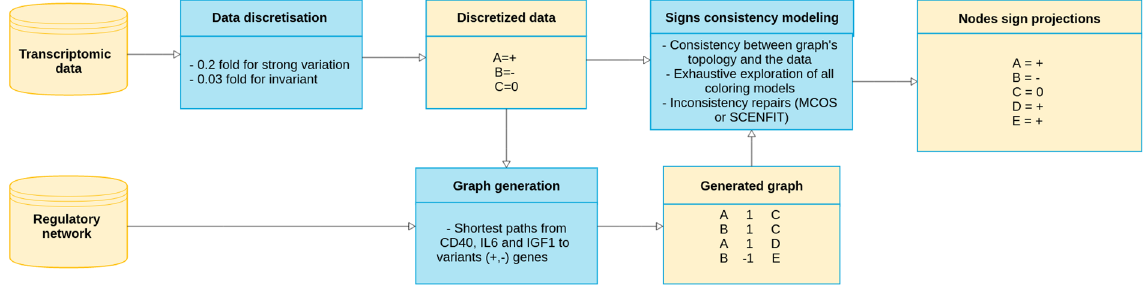
Figure 1. Overview of the sign consistency modeling